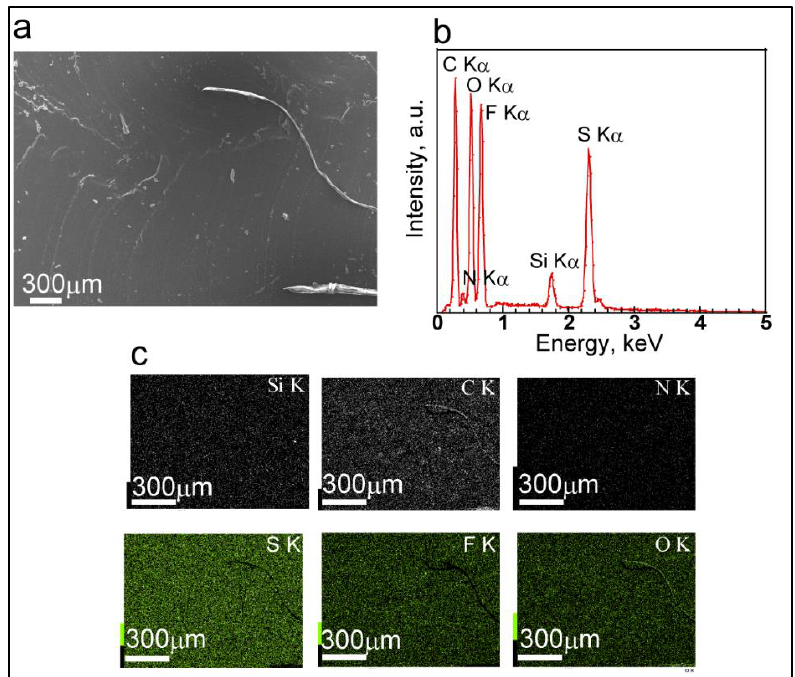
Figure 2. Surface SEM image ( a ), EDX spectra ( b ) and EDX mapping analysis data ( c ).